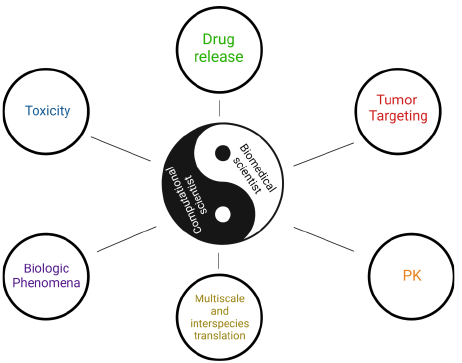
Figure 4. Implementation of biomedical research with computational modeling. Multidisciplinary collaborations between biomedical and computational researchers help to resolve complex issues including nanoparticle toxicity, drug release, targeting, pharmacokinetics, translation into different in vivo models, and understanding biological phenomena. MATLAB [67] is regularly used in many scientific fields, including systems biology [68]. In the case of PBPK models and related PBPK analyses, intermediate to advanced programming skills are required, which present a considerable disadvantage for its widespread use in the field [69]. MATLAB provides a range of mathematical and nu- merical methods for solving PBPK model equations, parameter estimation, and sensitiv- ity analysis [53–56,61,70–76]. In particular, several MATLAB toolkits can be used for modeling, simulating, and analyzing PBPK systems, namely SimBiology [57,77–80], Pot- tersWheel [81,82], and IntiQuan IQM Tools [70]. MATLAB was used to simulate the bio- distribution of NPs of different sizes in the range from 46 to 162 nm after intravenous injection into the plasma compartment of rats [54] (Figure 2B). The authors showed that the model reproduces the in vivo data from a study of the pharmacokinetics of mesopo- rous silica NPs [83] and then performed local and global sensitivity analyses to rank the importance of various parameters related to the problem of NP delivery to the tumor. Tumor vascularization (fraction and porosity), tumor blood viscosity, NP size and deg- radation rate have been shown as the main parameters to consider when calculating NP extravasation in the tumor volume, considering passive targeting as the major targeting mechanism. A similar approach was used to evaluate the biodistribution of dexame- thasone in a model of acute lymphoblastic leukemia [53] (Figure 2A). The model was based on experimental data obtained after intravenous injection of polymeric NPs. A fluorescent dye was used instead of the drug. The authors noted the difficulties in creat- ing a predictive model, in particular, in the first hours after injections, the model overes- timated the blood concentration of the dye. This phenomenon could be explained by particle aggregation and margination [84] in the endothelial wall, and to correct the model, they introduced an additional “other” compartment (i.e., lymphatic system). For longer time points, the model was consistent with the experimental data, demonstrating a rapid accumulation of the particles in the liver and spleen 6 h after their injections. This phenomenon was especially appreciated in consideration that liver and spleen are sites for leukemia blast accumulation and proliferation. MATLAB has also been used to de- velop a predictive model for tumor targeting of dendrimers functionalized with an insu- lin-like growth factor 1 peptide analog (NPs for molecular imaging that can bind to